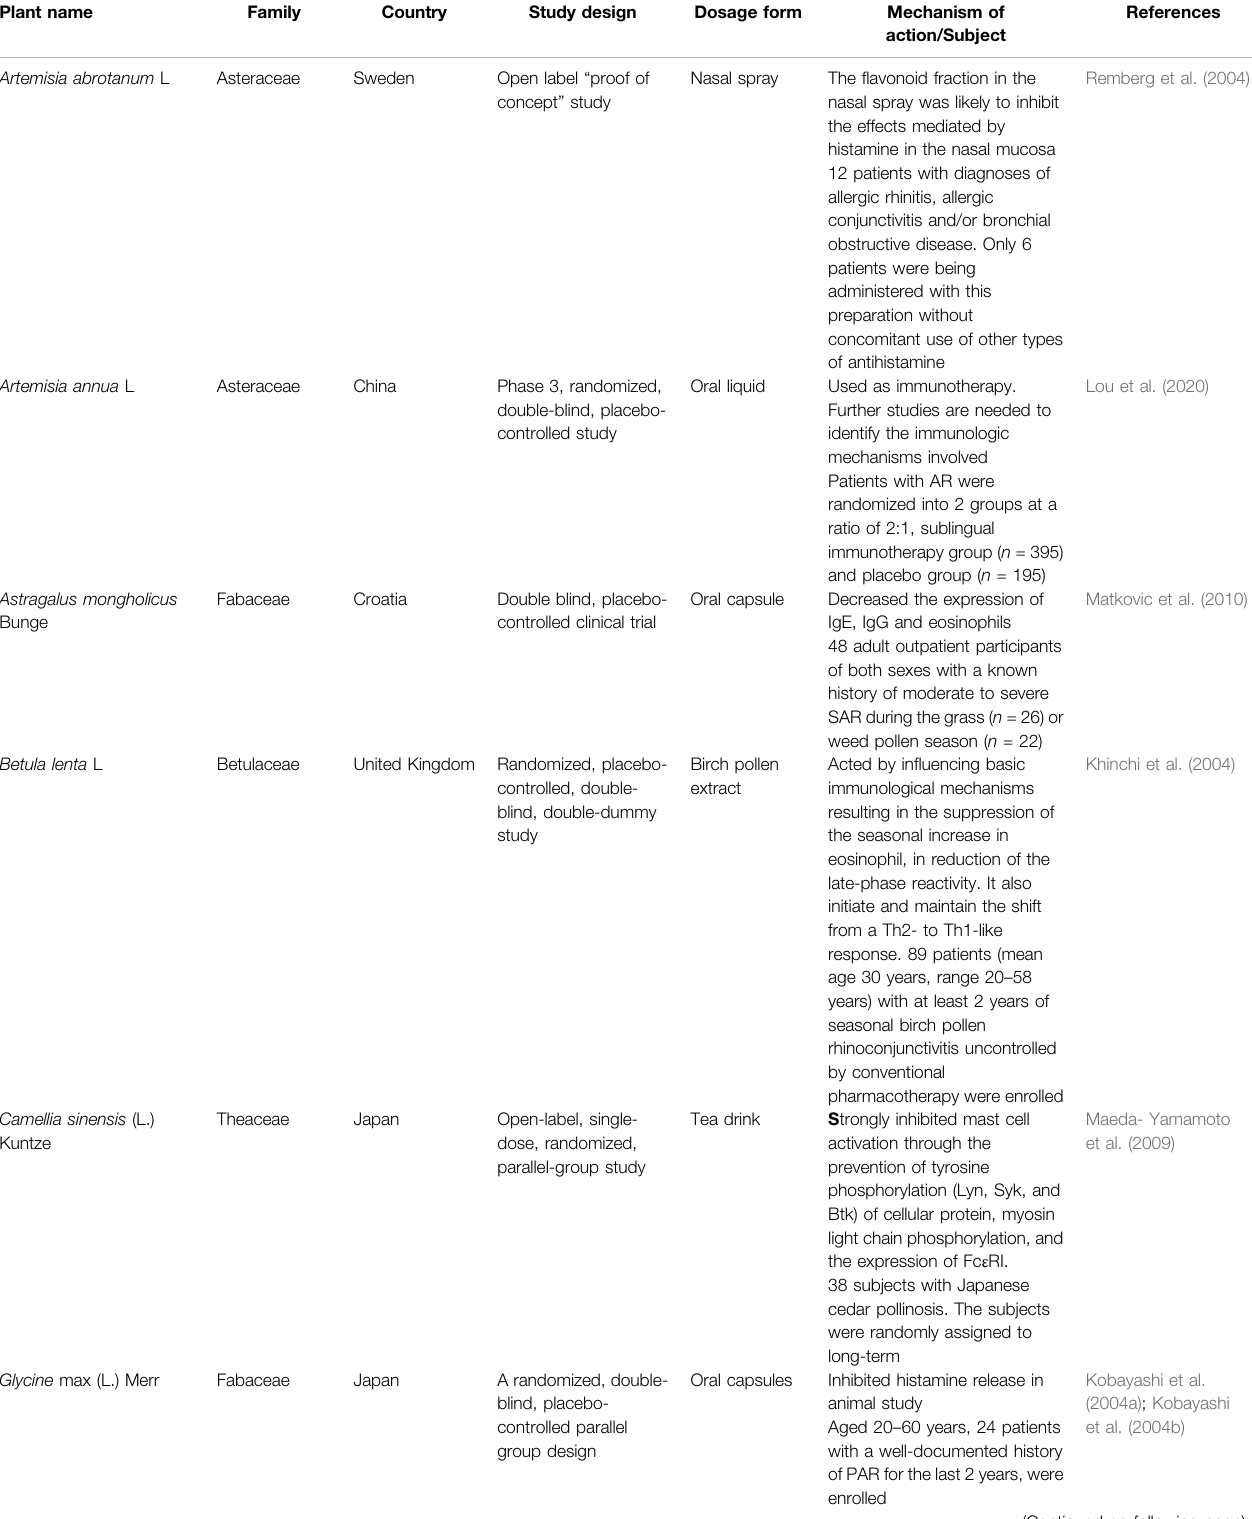
TABLE 2 | Clinical trials studies of plants with anti-allergic rhinitis. Plant